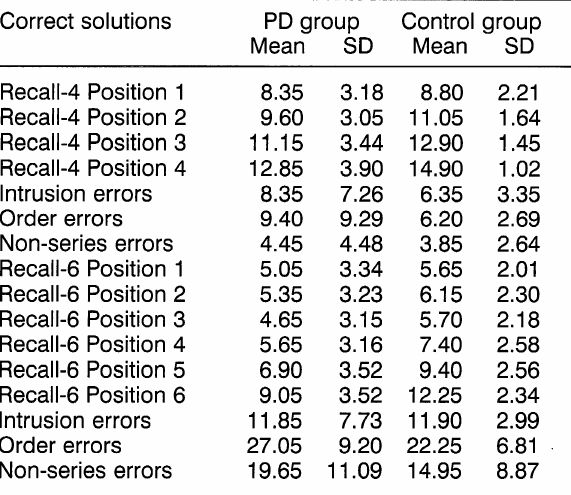
TABLE II: Mean scores for the PO and control subjects on the updating